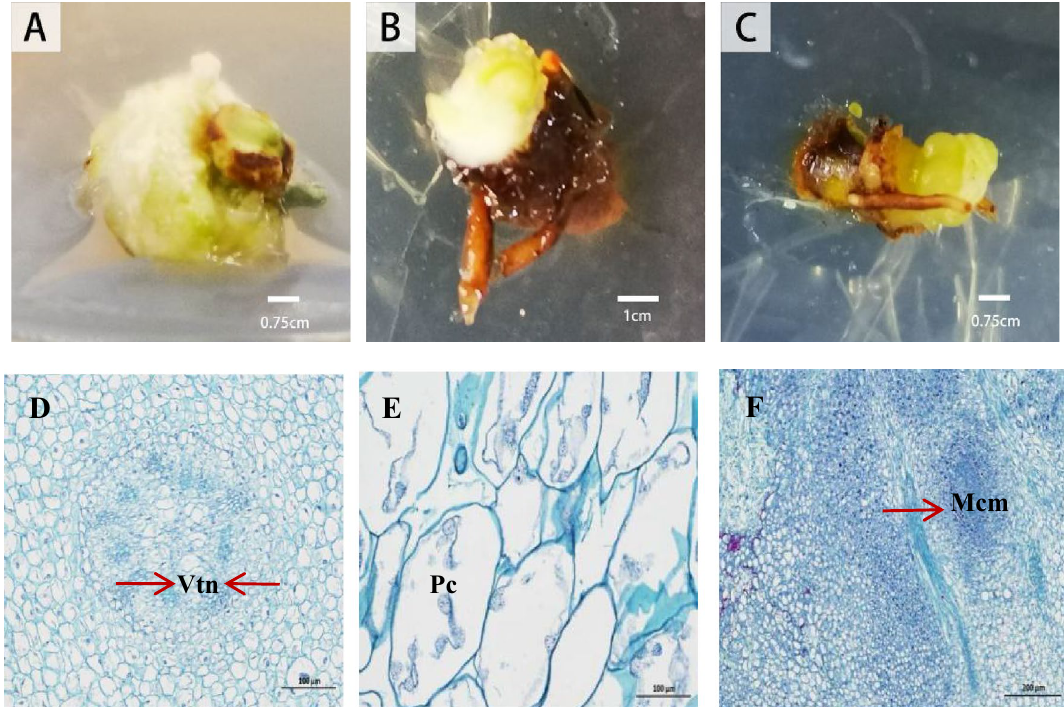
Figure 5. Three types of callus and their cytological observation. ( A , D ) external morphology and internal cell structure of callus type I; ( B , E ) external morphology and internal cell structure of callus type II; ( C , F ) external morphology and internal cell structure of callus type III. (Vtn-Vascular tissue nodules; Pc-Parenchyma cell; Mcm-Meristem cell